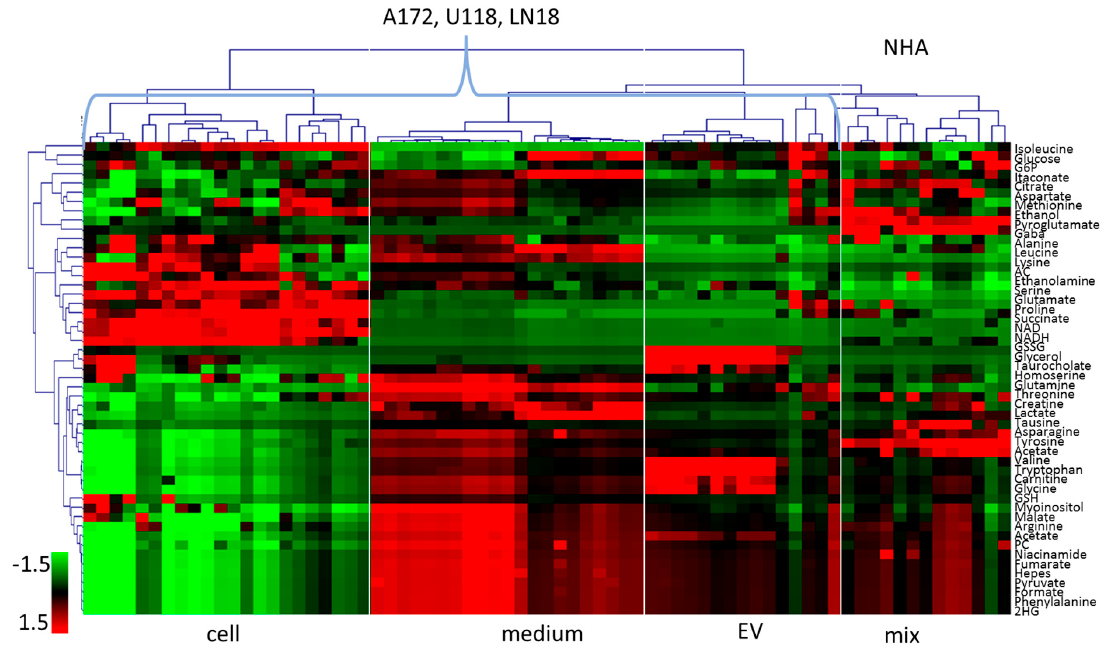
Figure 3. Relative concentrations of metabolites determined and quantified from NMR spectra. Metabolites are ordered using hierarchical cluster analysis across all samples. Values are scaled to mean of 0 and standard deviation of 1 across all samples and metabolites. AC—Adenosylhomocysteine; 2HG